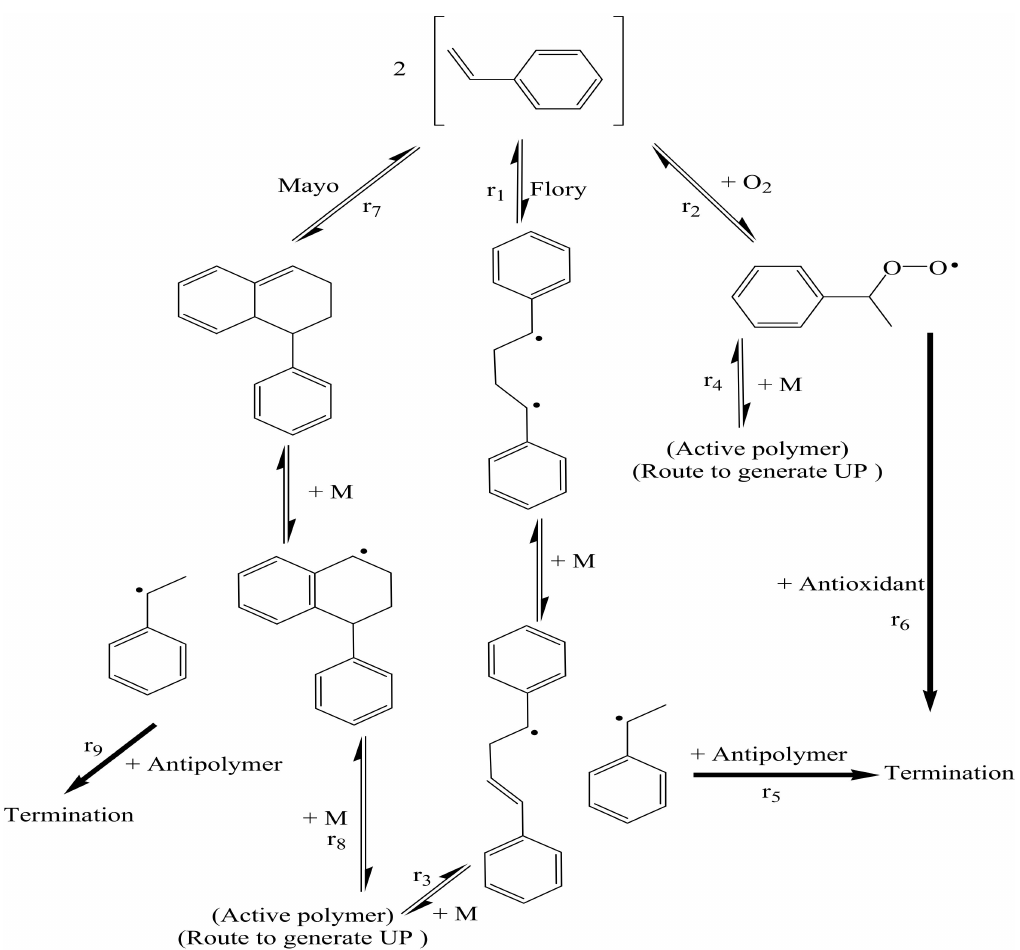
Figure 1. Reaction mechanism for styrene (ST) polymerization. Hydrogen atoms are omitted for